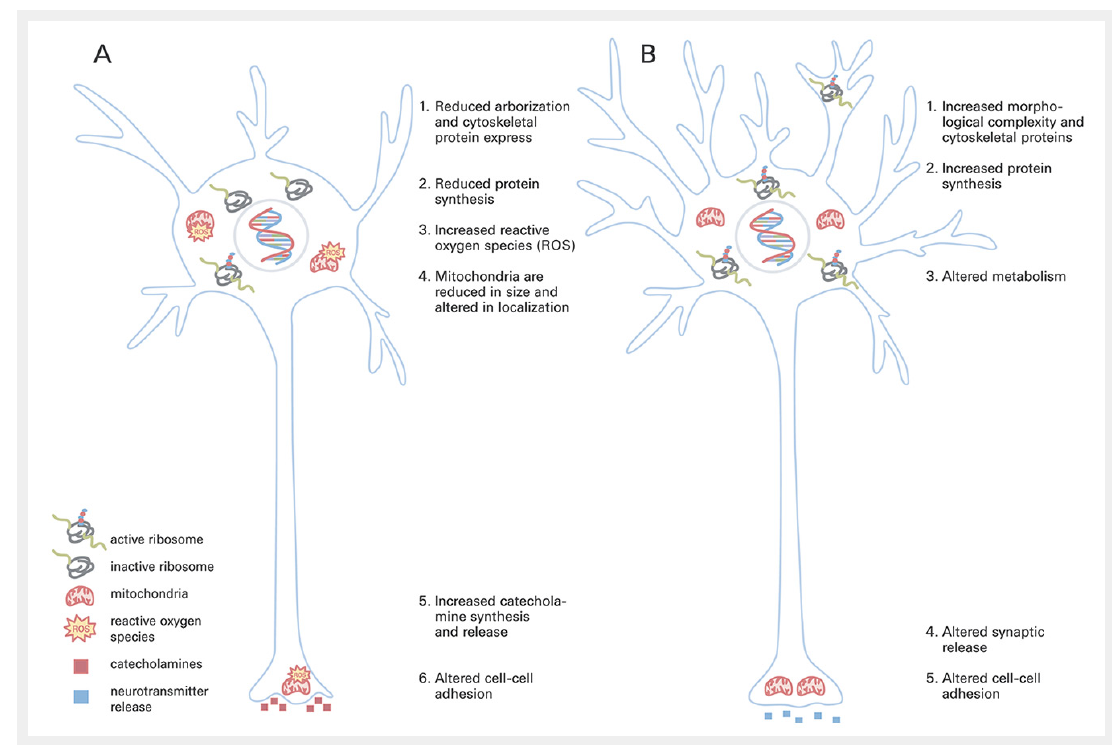
Figure 2 Schematic representation of reported changes to neurons in schizophrenia (A) and following antipsychotic treatment (B). Organelles are drawn to